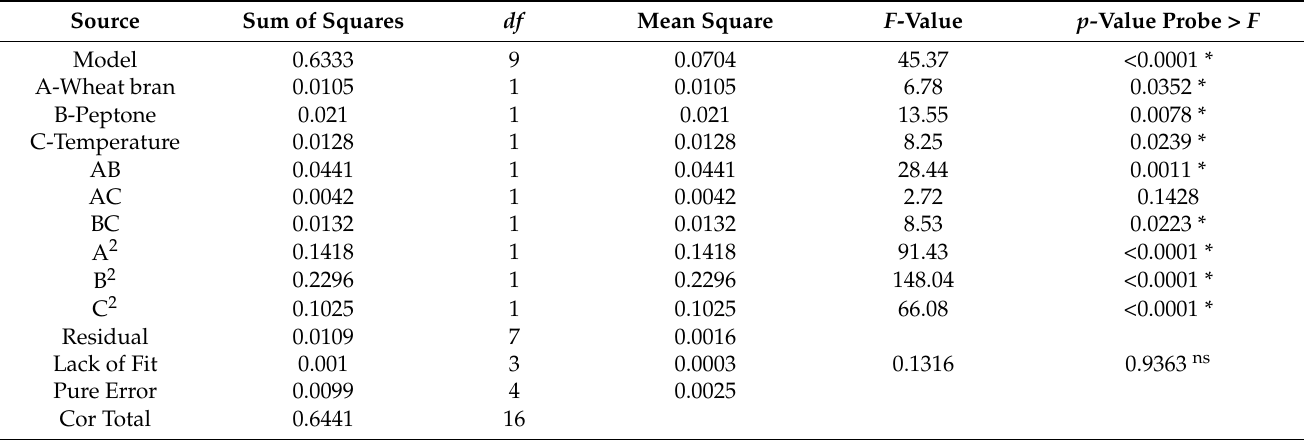
Table 3. ANOVA for PHB production as a function of independent